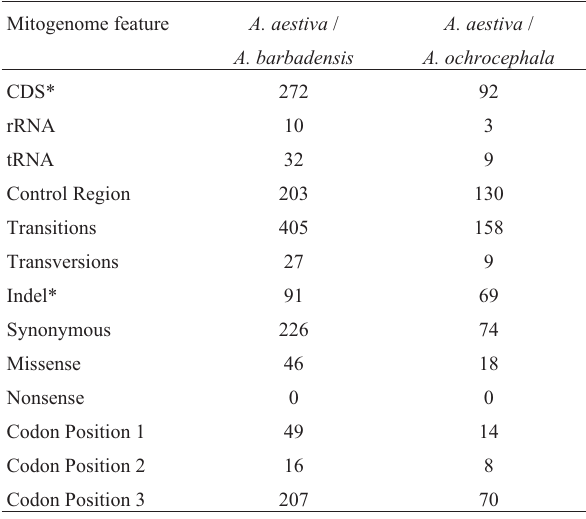
Table 2 - Number of single nucleotide polymorphisms when comparing the mitogenome of A. aestiva against the mitogenomes of A. barbadensis and A. ochrocephala